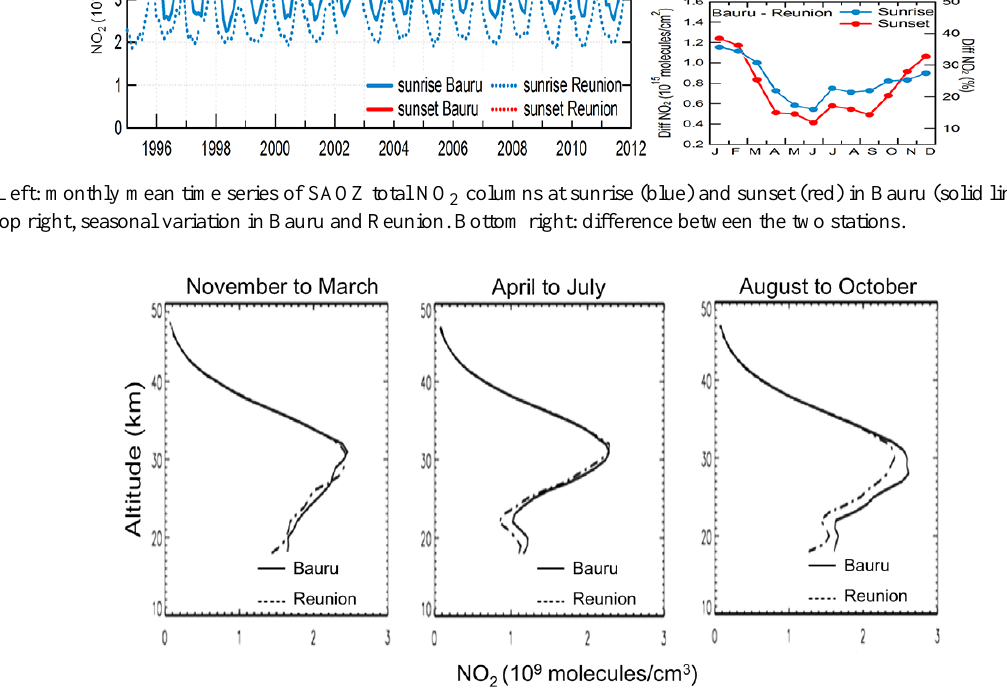
Figure 10. HALOE (1995–2005) NO 2 mean profiles over Bauru (solid line) and Reunion (dashed) in the November–March period (left), April–July (middle), and August–October